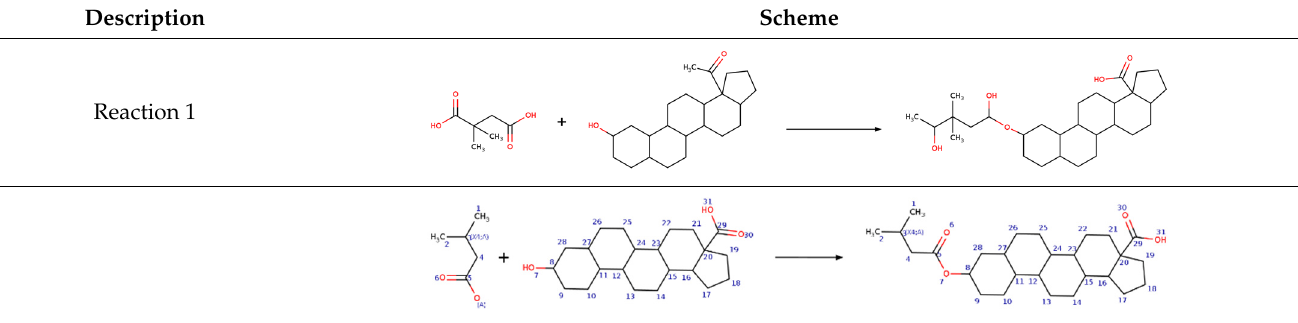
Table 2. SMIRKS used for building the new chemical compounds from natural products fragments. Description